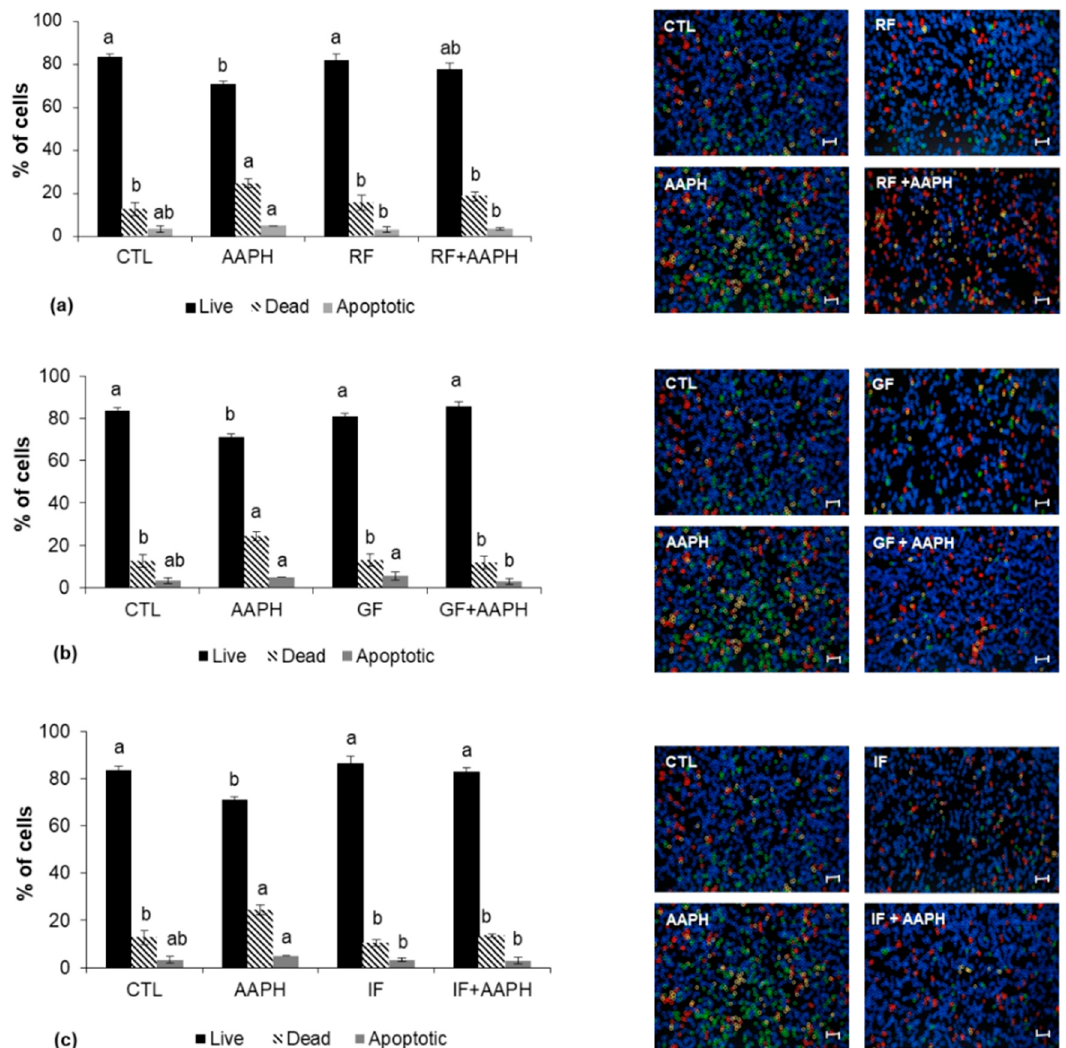
Figure 6. Percentage of live, dead, and apoptotic cells determined by the Tali ® Image-Based Cytometer. Cells were preincubated with ( a ) raw fruit; ( b ) fruit after gastric digestion; ( c ) fruit after